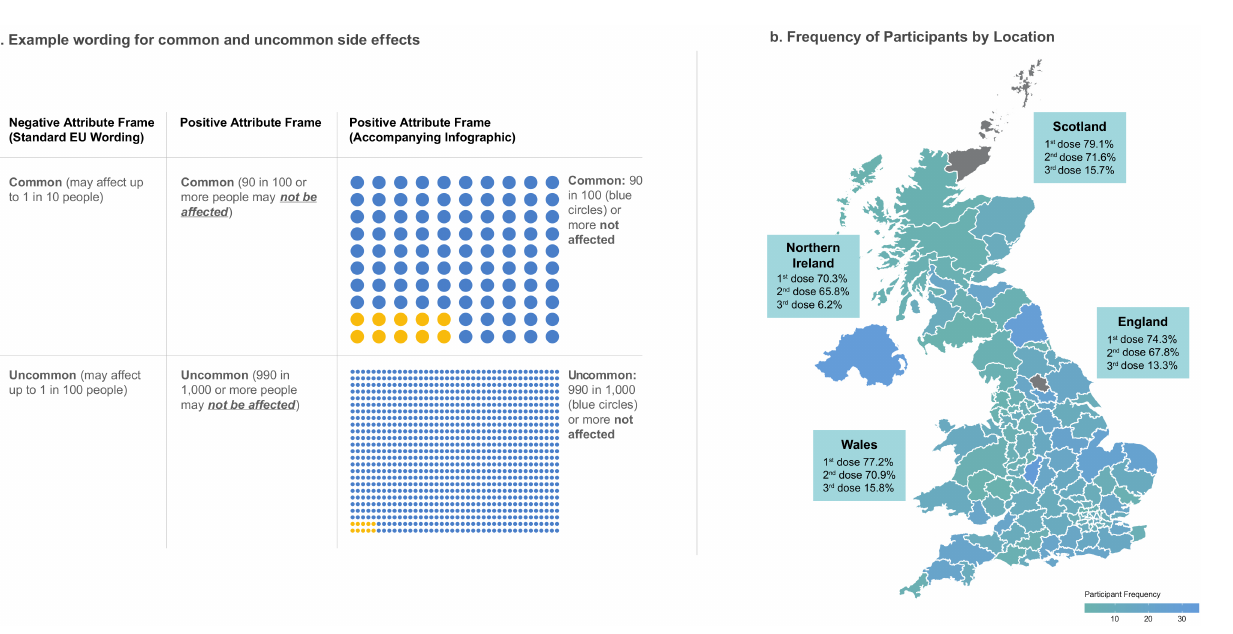
Figure 1. ( a ) . Positive and negative wording used to frame common and uncommon side effects (wording for all prevalence categories can be found in Supplementary Materials S1.3); ( b ). frequency of participants from each postal area of the UK plotted against the vaccination rates reported by the UK government on 3 November (the final week of data